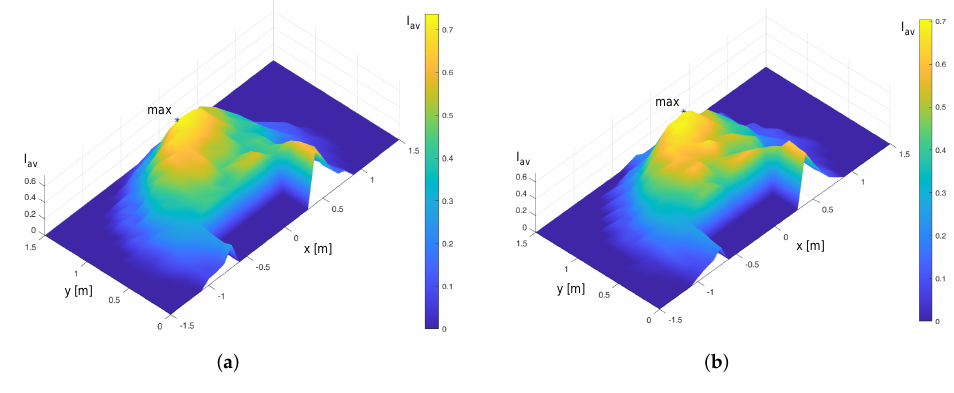
Figure 8. Interpolated maps of I av on plane I ( a ) and plane II ( b ).